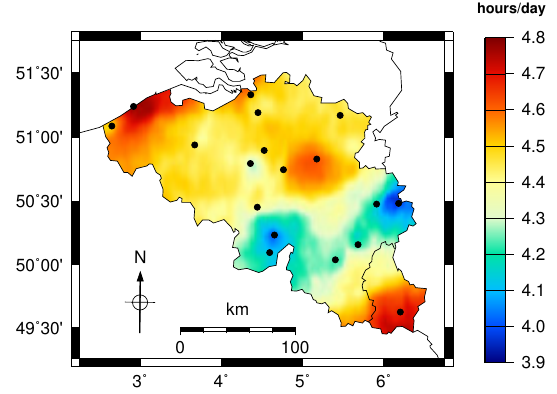
Figure 3. 1995–2005 mean map of the daily sunshine duration.